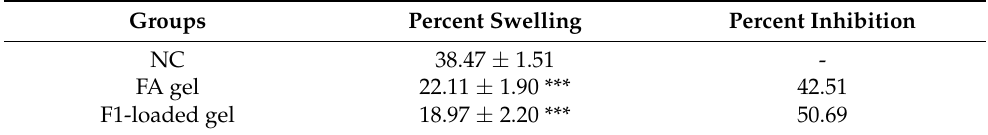
Table 4. Comparative anti-inflammatory activity on carrageenan-induced paw edema.